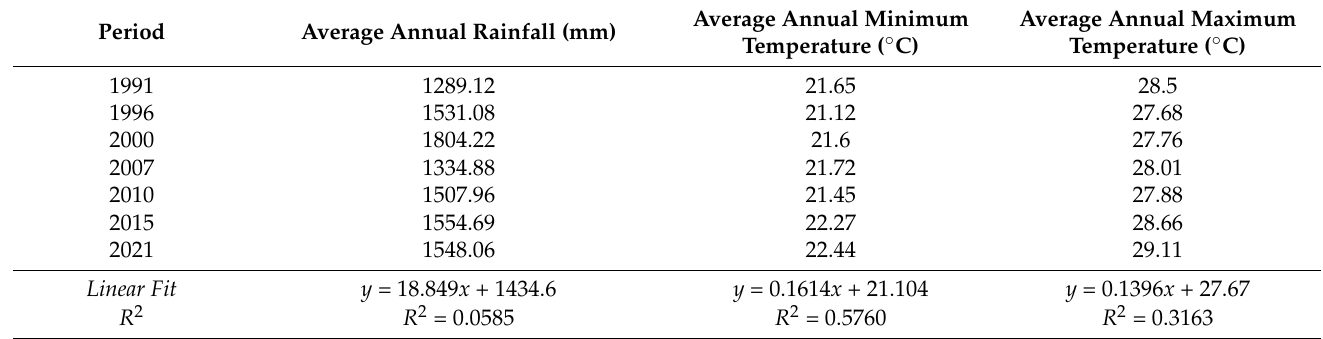
Table 6. Climate and environmental indicator dynamics in the Hainan Island during 1991–2021.